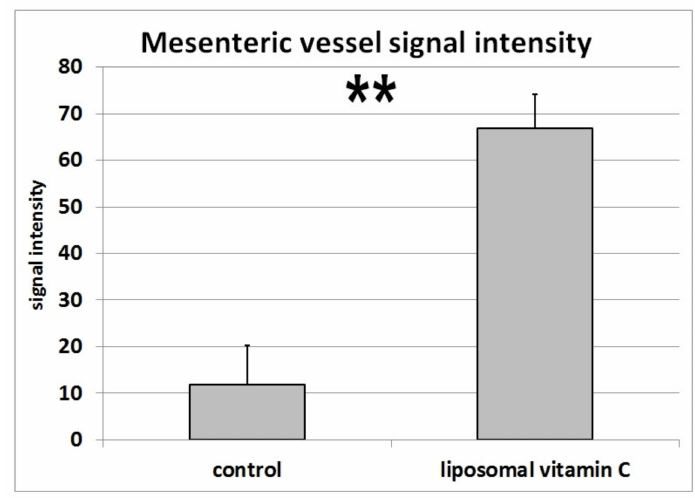
Figure 5. Microbubble signal intensities in mesenteric vessels prior to and following oral vitamin C application for all four patients. Mean and Standard derivations are shown ( p -value: 0.0013 (**: p -value < 0.01)).